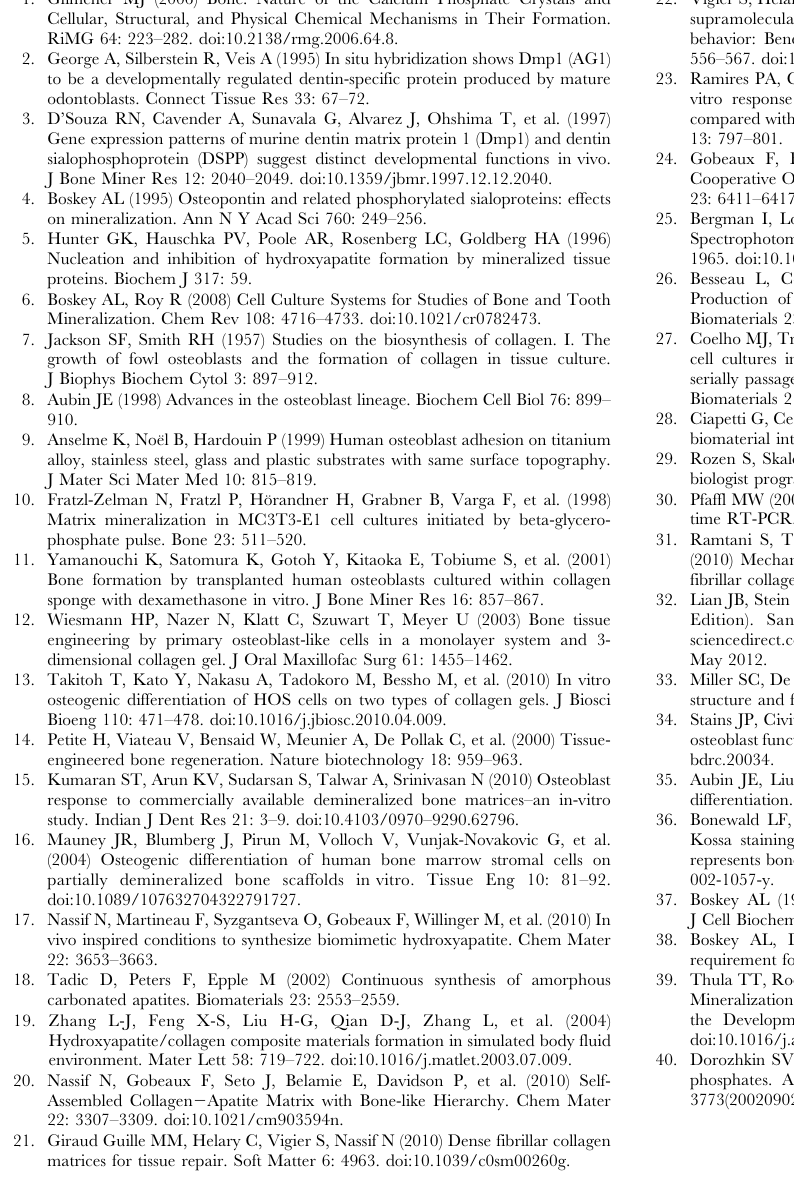
Table S2 Osteoblast